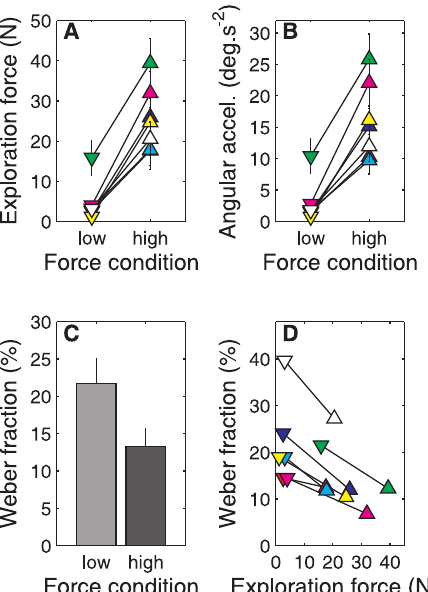
Figure 4. Results of Experiment 1. A: Magnitude of the exploration force for each individual participant in both force conditions. The colors indicate individual participants; the error bars indicate one standard deviation. The yellow symbols indicate the exemplary participant in Figure 3. B: Magnitude of the angular acceleration (details as in A). The graphs in A and B are very similar because force and angular acceleration are linearly related (see equation 1). Yet, there are small differences between panels A and B because, for example, a high exploration force in a stimulus with a low moment of inertia leads to a higher angular acceleration than if it were a stimulus with a high moment of inertia. C: Average Weber fractions in the low force and high force conditions. The error bars indicate the standard error over participants. D: Relationship between exploration force and Weber fraction for each individual participant (color coding as in A and B).